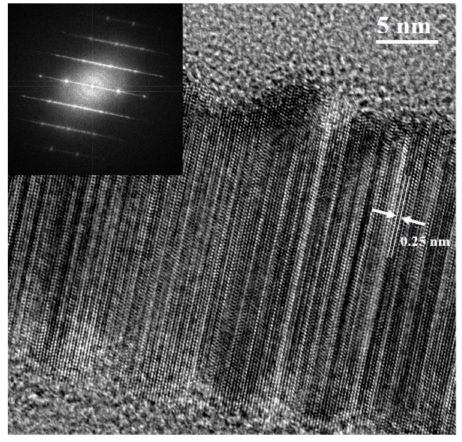
Figure 3. HRTEM image of a SiC NW with its corresponding selected area electron diffraction pattern (inset).